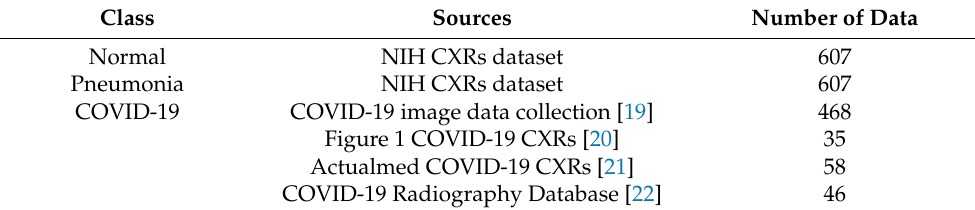
Table 1. Number of data for each class used in this study and its